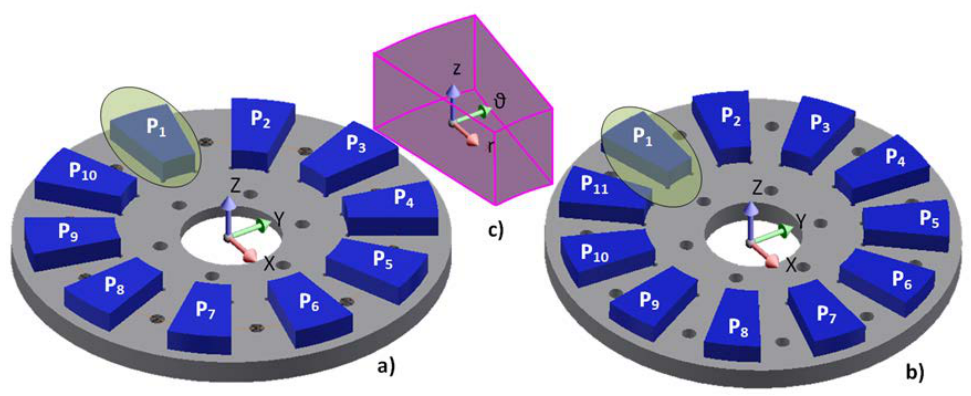
Figure 4. ( a , b ) Pole pieces numbering for MG 1 and MG 2, respectively; ( c ) local coordinate system assigned to any core.